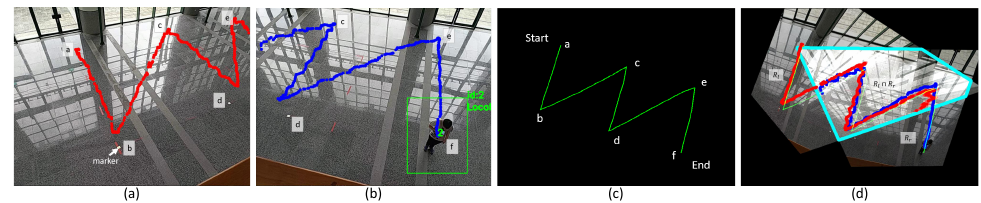
Figure 3. ( a ) Trace found by C 1 . ( b ) Trace found by C 2 . ( c ) IMU trajectory partitioned by markers. ( d ) Overlapping region R 1 ∩ R 2